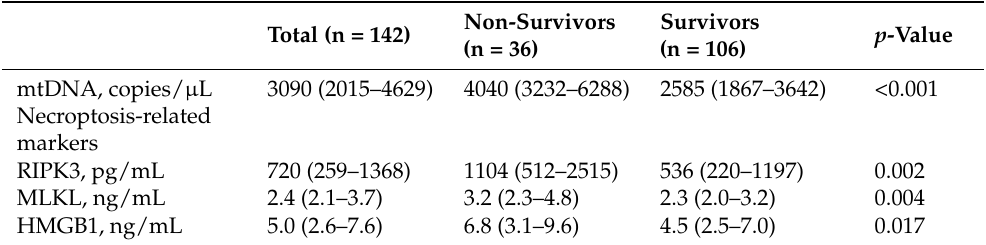
Table 2. Plasma levels of mtDNA, RIPK3, MLKL, and HMGB in non-survivors versus survivors among critically ill patients with sepsis. Data are presented as median (interquartile range).